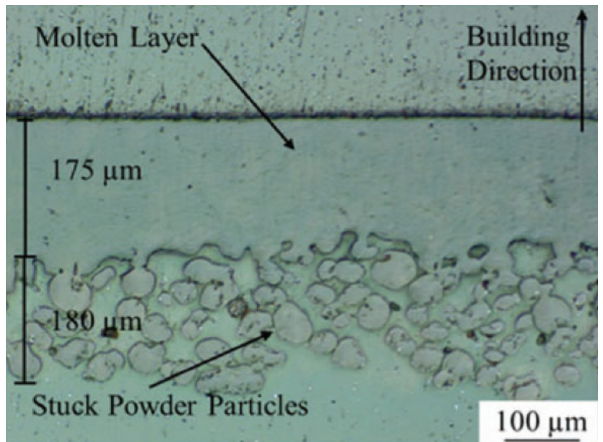
Figure 43. Cross-section of molten PA12 after 10 s simultaneous melting by a thulium laser, which is an integral step in the SLBM fabrication process. This study uses polypropylene (PP) and polyamide 12 (PA12) powder to print a multi-material part, where the resulting layer thickness is 175 µ m. (Reprinted with permission from [167]. Copyright (2015), Laser Institute of America).